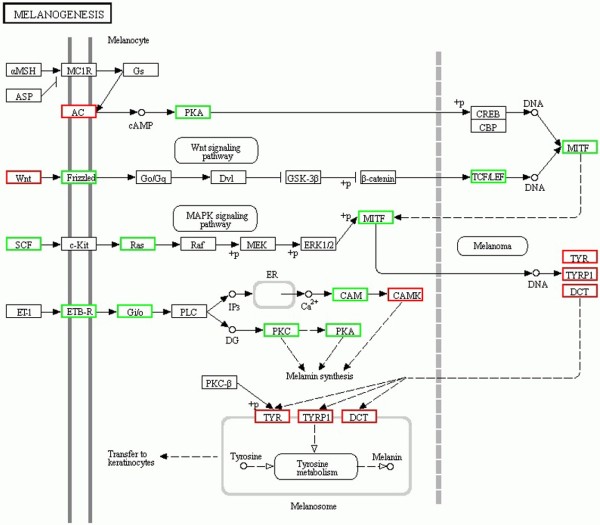
Differentially expressed coat color genes in sheep skin and their involvement in the melanogenesis pathway. Genes with red frame are up-regulated and genes with green frame are down-regulated in black versus white sheep skin.